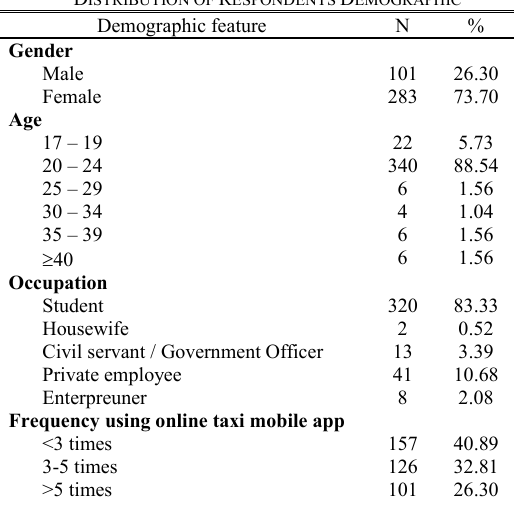
TABLE 3 D ISTRIBUTION OF R ESPONDENTS D EMOGRAPHIC